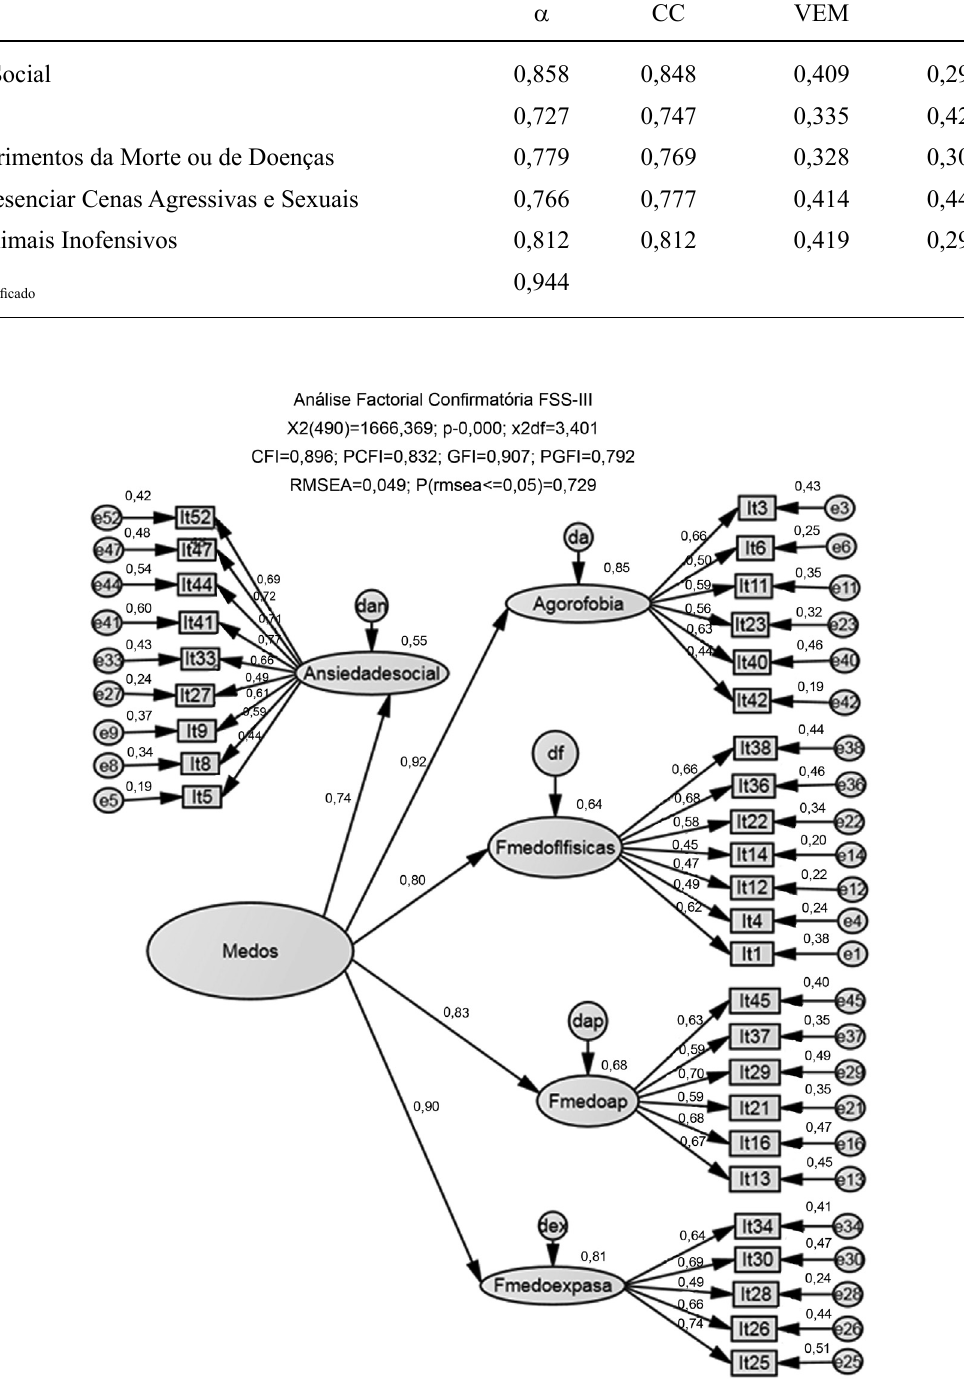
FSS III – Análise da Consistência Interna (  ), da Con fi abilidade Composta (CC), da Variância Extraída Média (VEM)